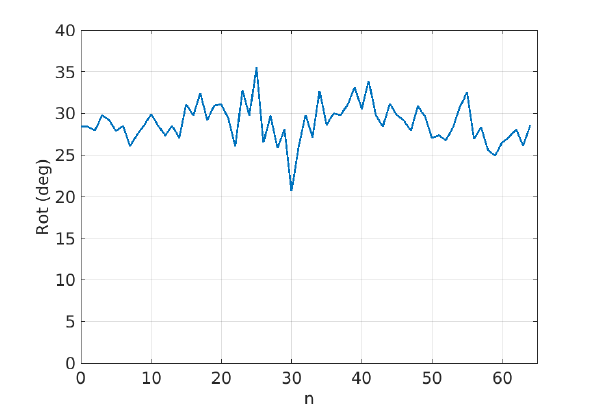
Figure 20. Sequence of estimated rotations for the coconut sequence with ∆ n = 20.